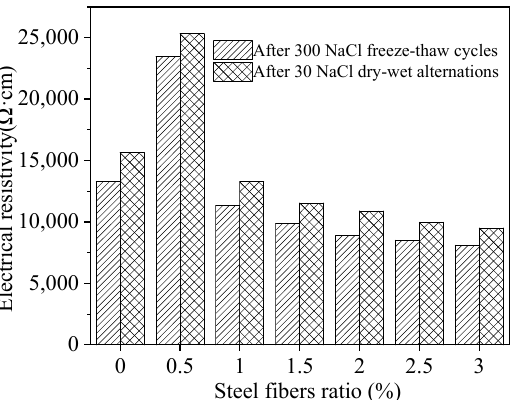
Figure 18. The electrical resistivity of the passive film through equivalent circuit diagram.